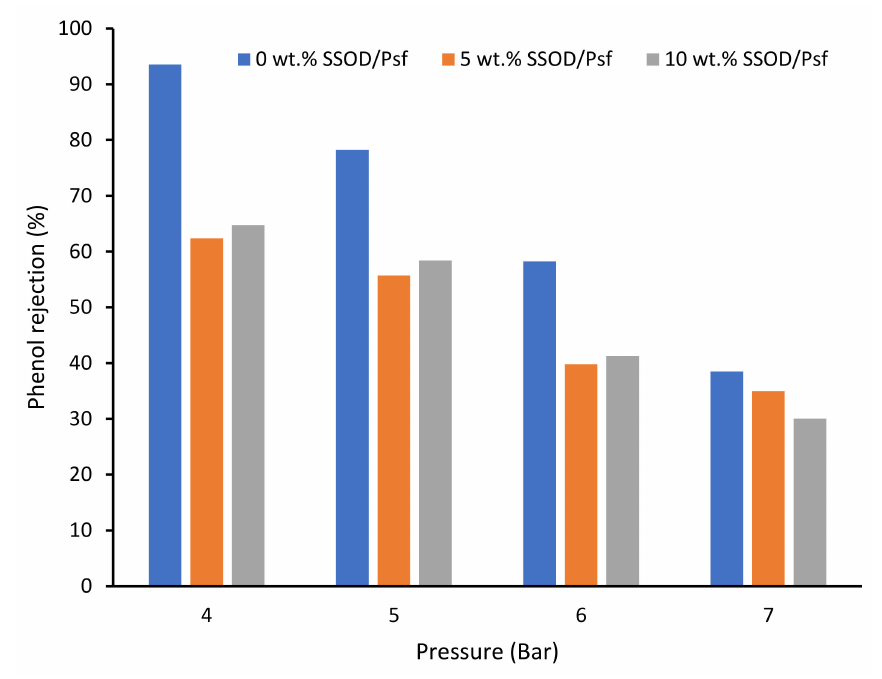
Figure 10. Phenol rejection of membranes at different